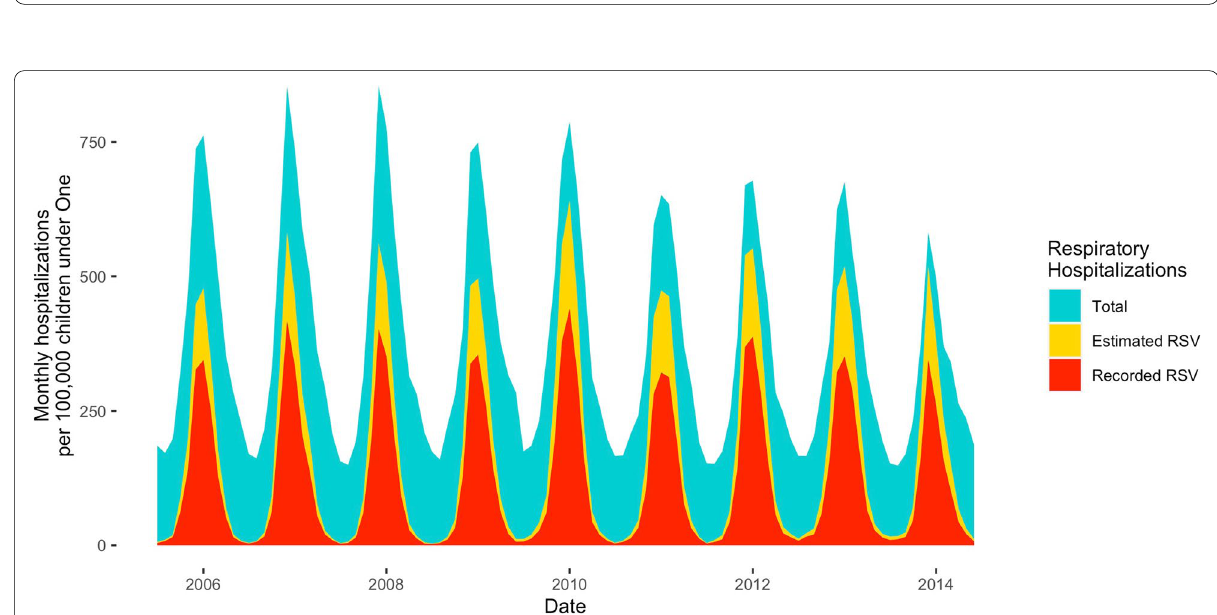
Fig. 3 Monthly respiratory hospitalizations among older adults, July 2005—June 2014. The blue area in the left panel shows the total monthly respiratory hospitalization rate among adults aged 65 and above; the yellow area shows the estimated monthly RSV-associated respiratory hospitalizations in the same age group and the red area shows the hospitalizations recorded as RSV each month. The right panel zooms in to show the increasing trend of recorded RSV diagnoses